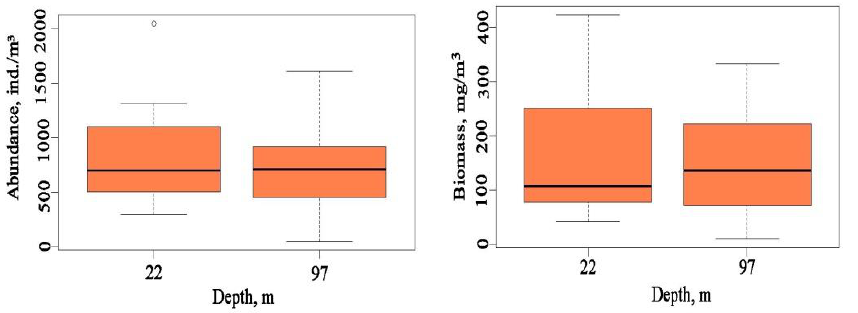
Figure 3. Quantitative variables of Evadne nordmanni in different depths of the Middle Caspian Sea.